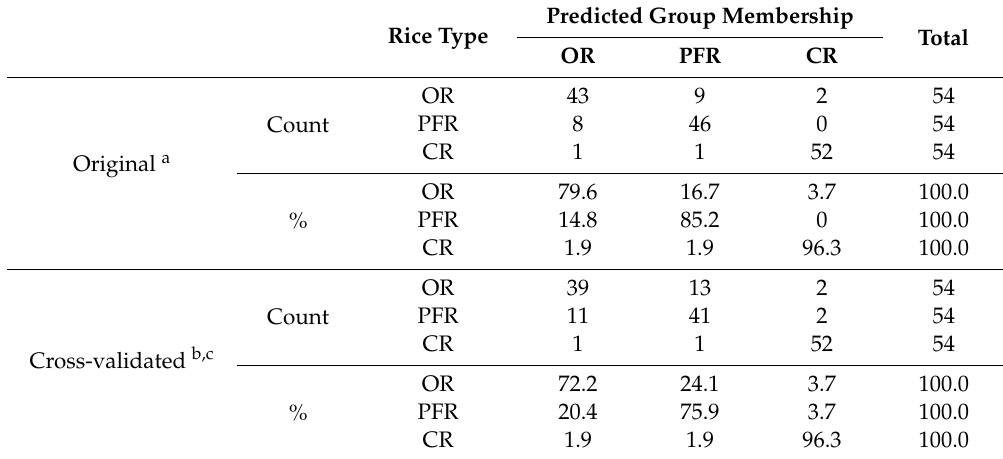
Table 1. Classification and cross-validated results of rice types (OR, PFR, and CR) identified using